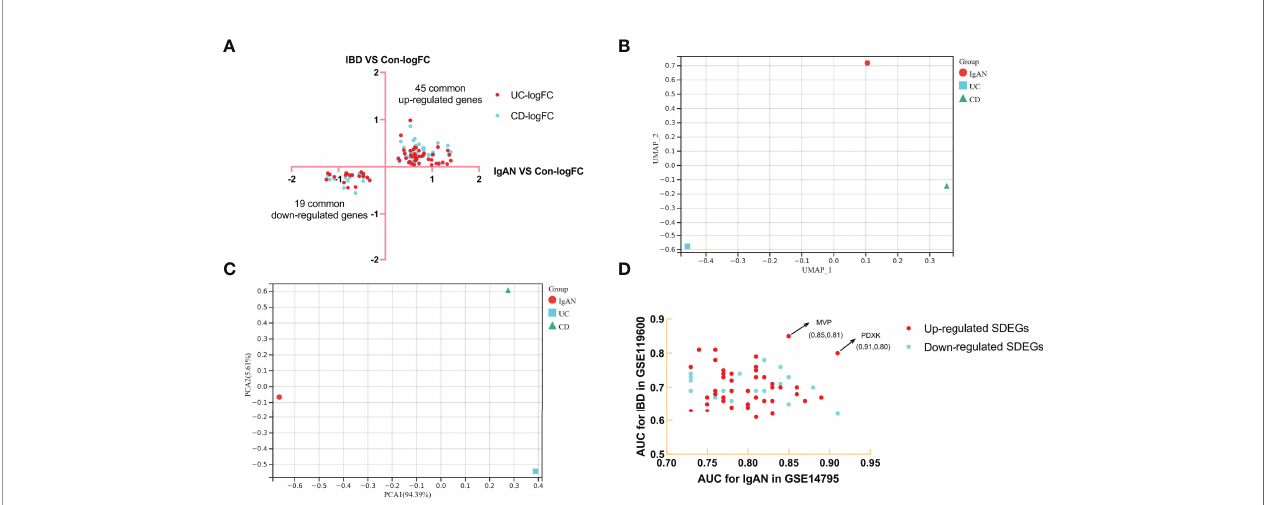
FIGURE 2 | Identi fi cation of SDEGs of IgAN and CD, dimension reduction analysis and AUC calculation. (A) FC-FC plot of IgAN and IBD, there were 45 common up-regulated genes and 19 common down-regulated genes. (B) UAMP analysis of SDEGs log 2 FC in IgAN, UC, and CD. (C) PCA analysis of SDEGs log 2 FC in IgAN, UC, and CD, IgAN is closer to CD than IgAN is to UC in both UAMP and PCA analysis. (D) AUC-AUC plot of IgAN and IBD, the AUC of MVP and PDXK in IgAN and IBD were both ≥ 0.8.